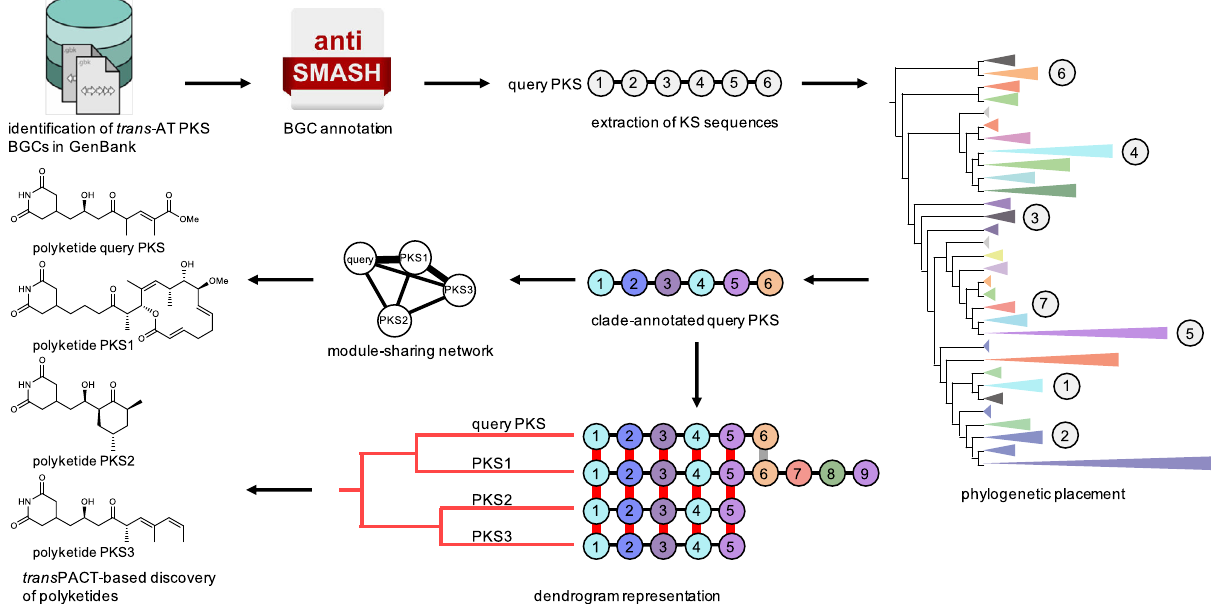
Fig. 1 trans PACT Work fl ow. One thousand seven hundred eighty two trans- AT PKS BGCs were retrieved from GenBank and subjected to antiSMASH analysis 38 . Trans -AT PKS KS sequences were extracted, followed by phylogenetic placement to annotate query KS sequences that correlate with substrate speci fi city. Module sharing networks and dendrogram representations were computed and used for, e.g., subsequent genome mining studies resulting in the isolation of novel members of trans -AT PKS families, the identi fi cation of novel trans -AT PKS scaffolds, and culturable representatives of uncultured producers of polyketides and evolutionary